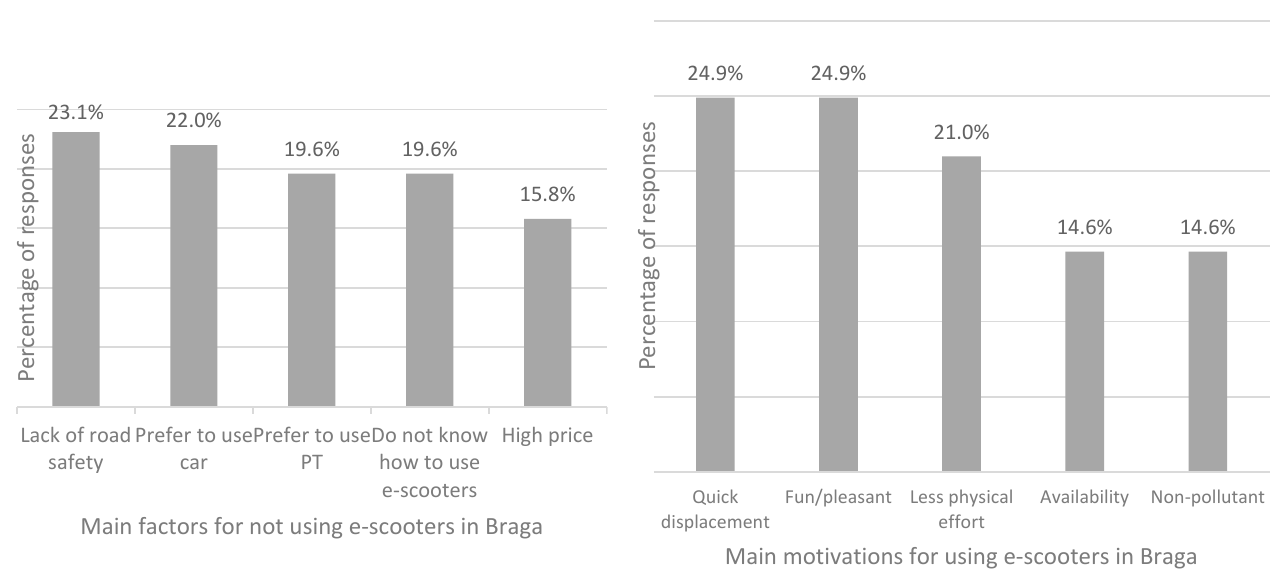
Figure 5. The main factors affecting shared e-scooter usage in Braga: ( a ) Main factors for not using shared e-scooters in Braga; ( b ) Main motivations for using shared e-scooters in Braga.